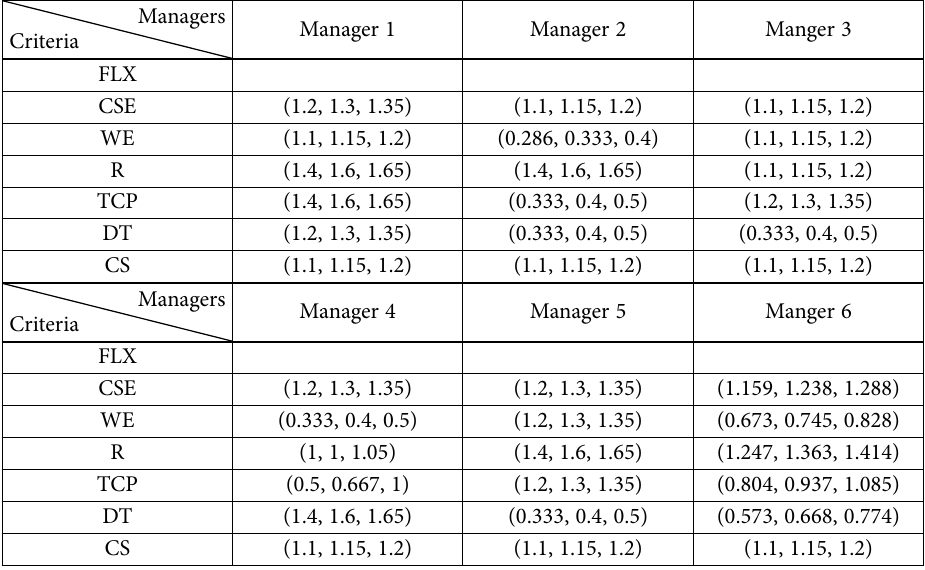
Table 5. The inverse fuzzy PIPRECIA assessment